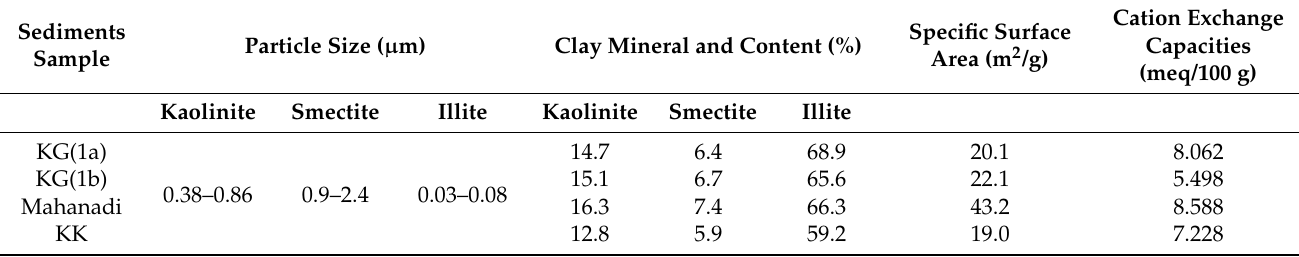
Table 9. Specific Surface Areas (SA) and Cation Exchange Capacities (CEC) of